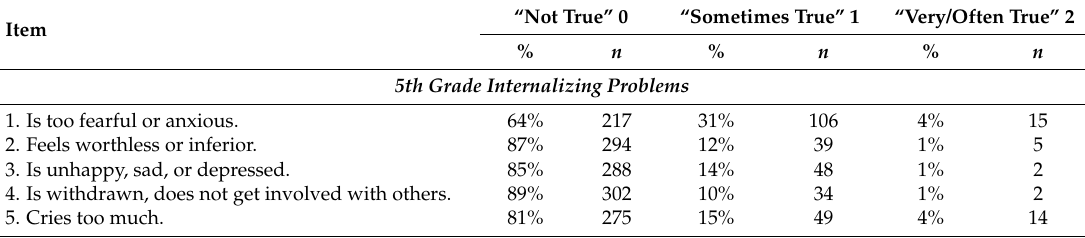
Table A1. Descriptive statistics of parent reported child internalizing behavior problem in middle childhood ( n = 338) 1,2